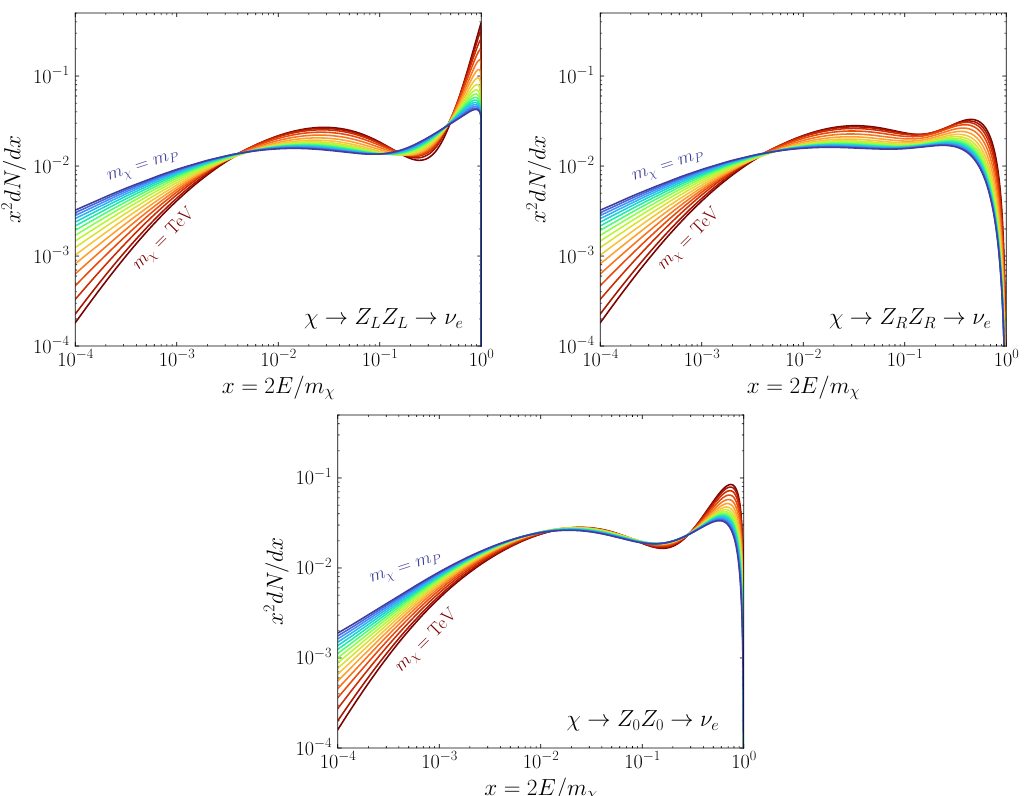
Figure 13 . A further analog of figure 3, here for the electron neutrino spectrum from DM decay to Z -bosons. In this case, instead of averaging over the three available initial polarizations, we depict each polarization separately: left (top left) and right (top right) handed initial states (top left), and longitudinally polarized bosons (bottom). Once more, a separate curve is shown for each decade in DM mass between a TeV and the Planck